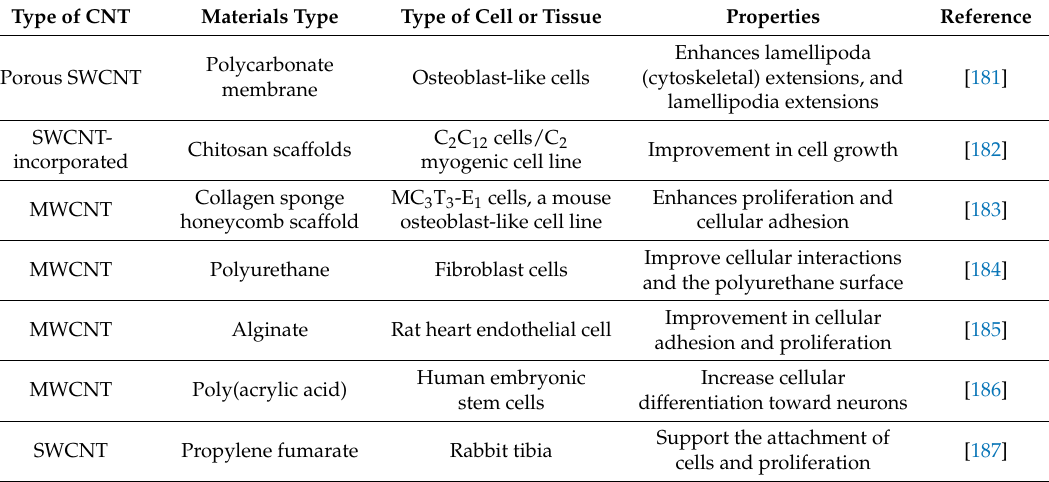
Table 4. Applications of CNTs as artificial implants.